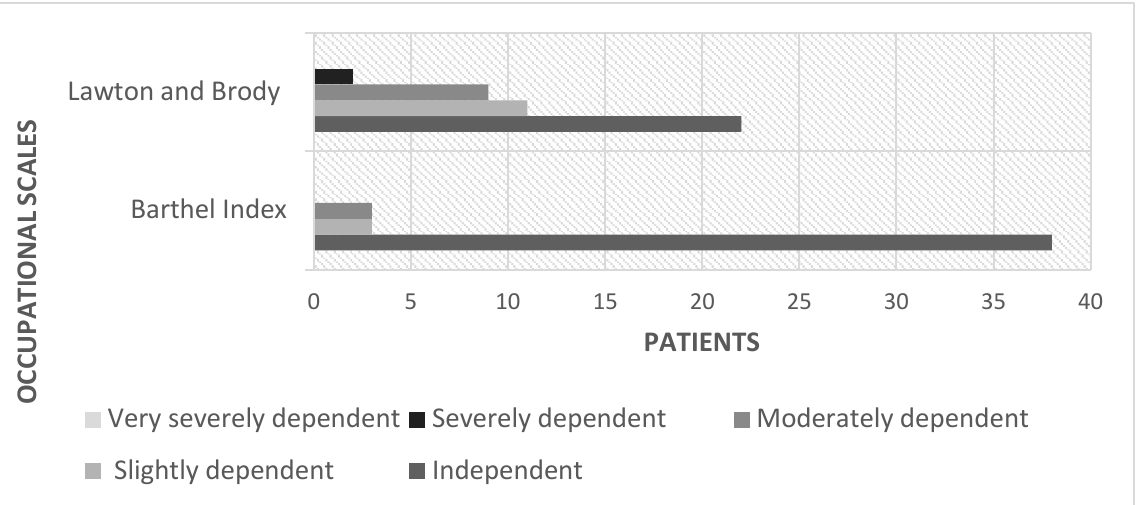
Figure 1. The proportion of patients with difficulties in basic and instrumental activities of daily living.